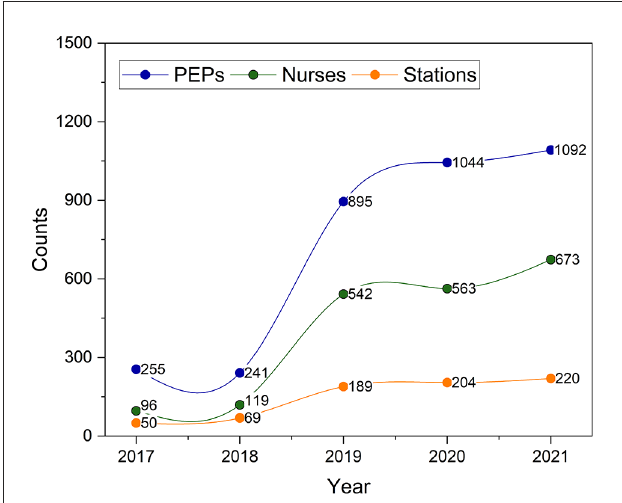
FIGURE1 Number of medical emergency stations, PEPs, and nurses in Tianjin. PEPs, prehospital emergency physicians.